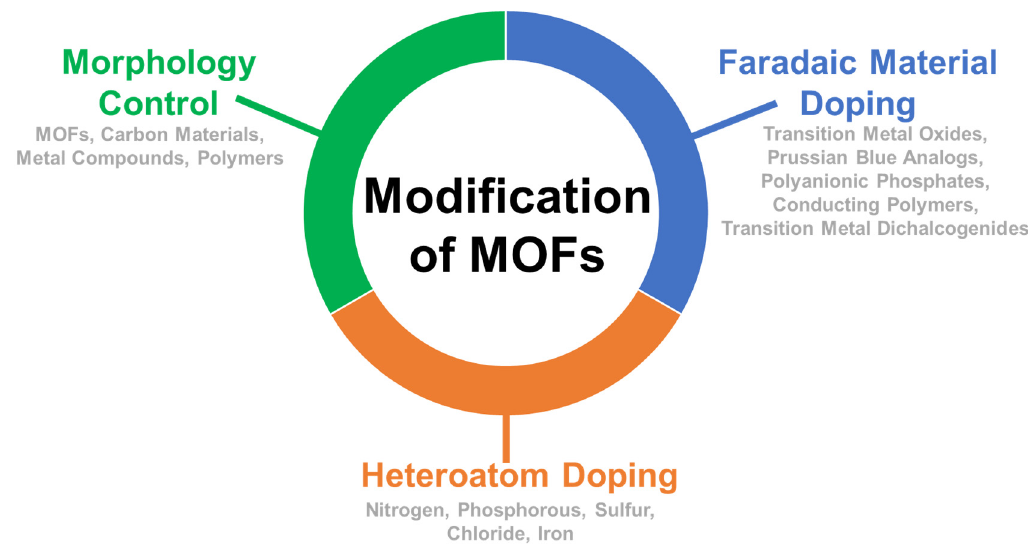
Figure 7. Examples of MOFS modification processes that enhance the electrochemical performance [37].